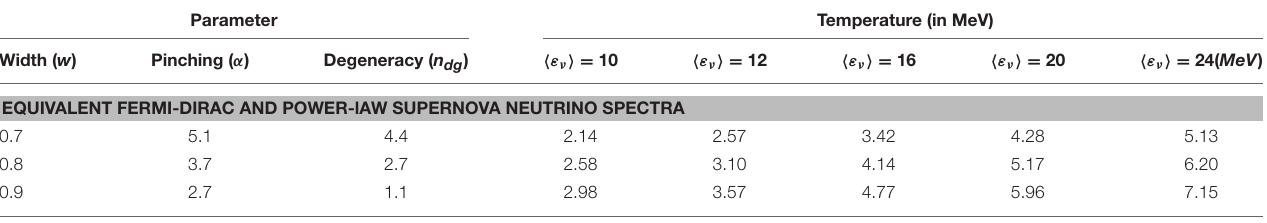
TABLE 3 | Calculated values for the flux averaged coherent cross sections Isotope Geo-Neutrinos Reactor neutrinos